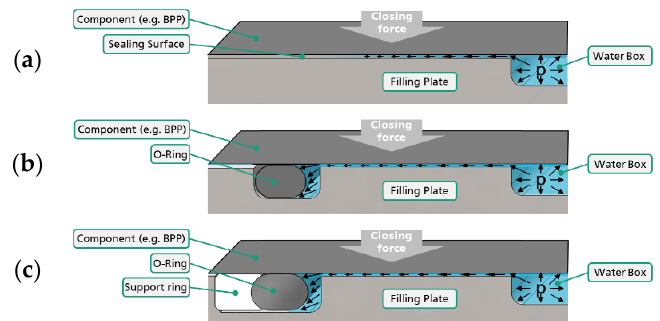
Figure 4. Working principles of the sealing systems developed: ( a ) without additional sealing element, ( b ) sealing by means of an O-ring, ( c ) sealing by means of a combination of O-ring and support ring. An O-ring (Ø3 mm, NBR70 acc. to ISO 3601) arranged in a groove (Figures 4b and 5a)